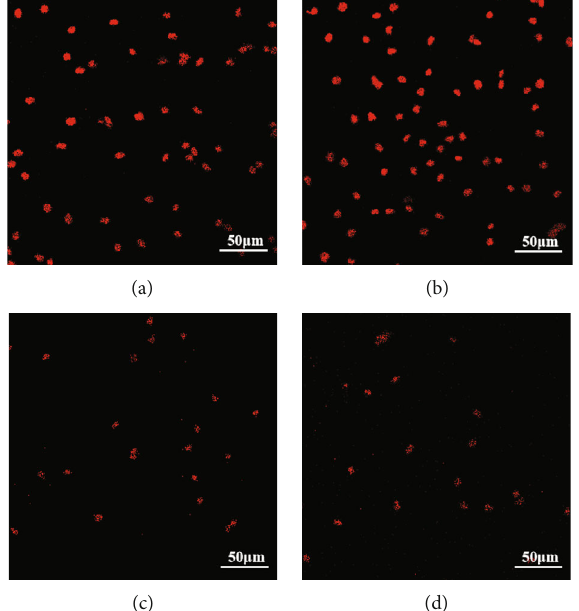
Figure 4: CAL-27 cell apoptosis detection after chemotherapy. (a) Apoptosis level of CAL-27 cells without treatment. (b) Apoptosis level of CAL-27 cells with ULK1 overexpression. (c) Apoptosis level of CAL-27 cells with ULK1 downexpression. (d) Apoptosis level of CAL-27 cells with ULK1 downexpression and miR-214